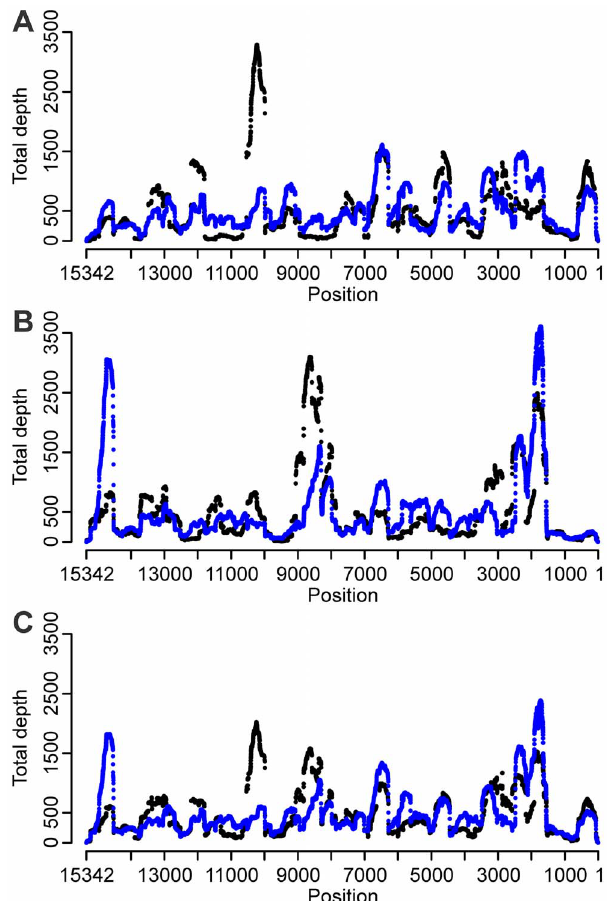
Figure 4. Effect of the SISPA primer sequence (random part and tag) on sequence depth distribution. (A) FR20RV-6N (black) and FR20RV-12N (blue). (B) K-6N (black) and K-12N (blue). (C) In silico combined conditions ‘‘FR20RV-6N + K-6N’’ (black) and ‘‘FR20RV-12N + K- 12N’’ (blue).